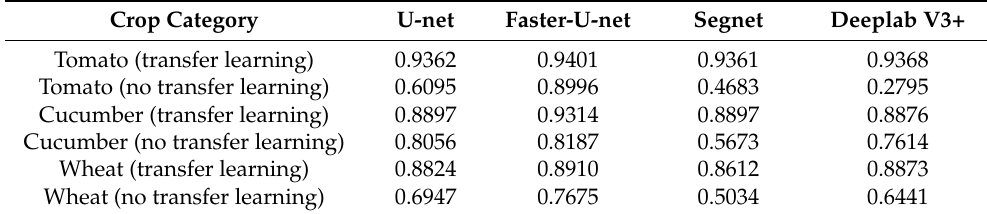
Table 4. Faster-U-net transfer learning MIoU results